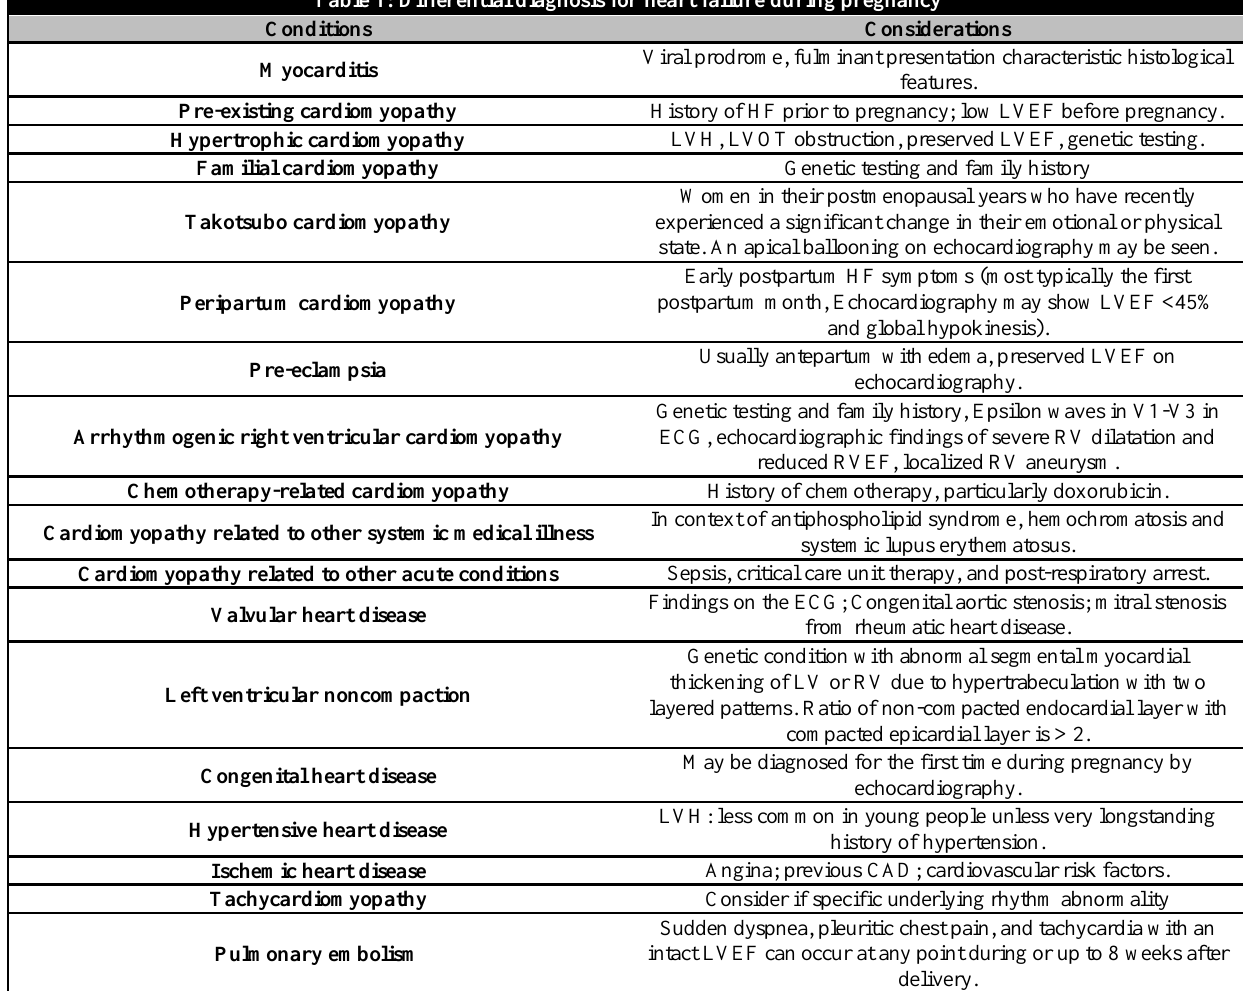
Table 1: Differential diagnosis for heart failure during pregnancy